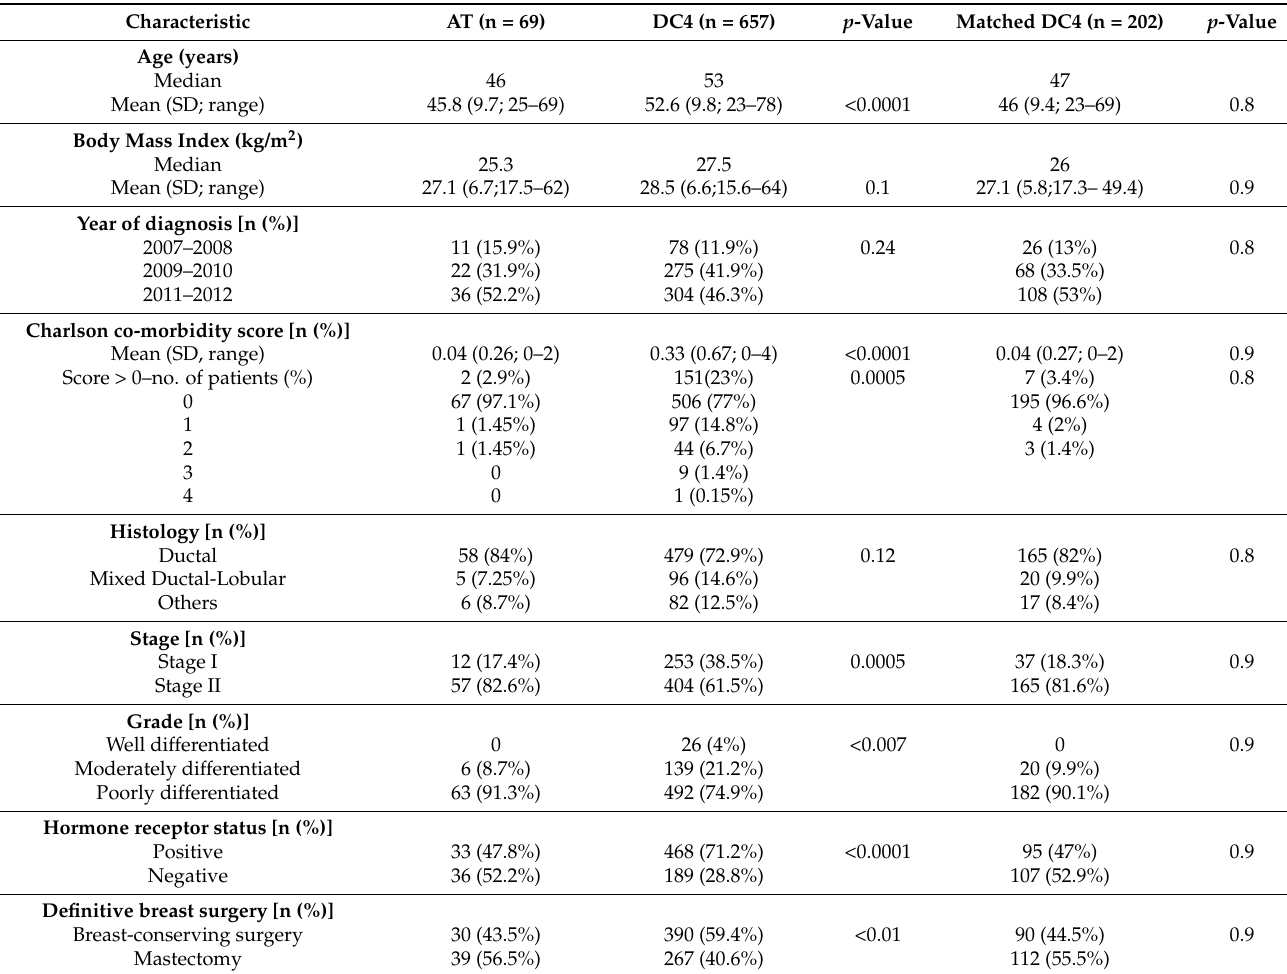
Table 1. Baseline patient, tumour, and treatment characteristics of patients in the anthracycline-taxane (AT), overall docetaxel-cyclophosphamide for four cycles (DC4) and matched DC4 groups.